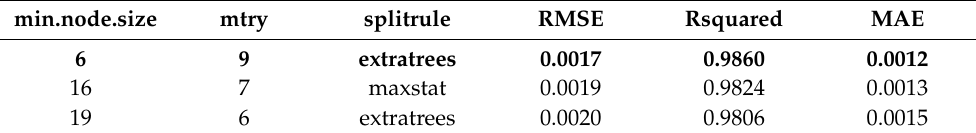
Table 6. Ordinary random forest.